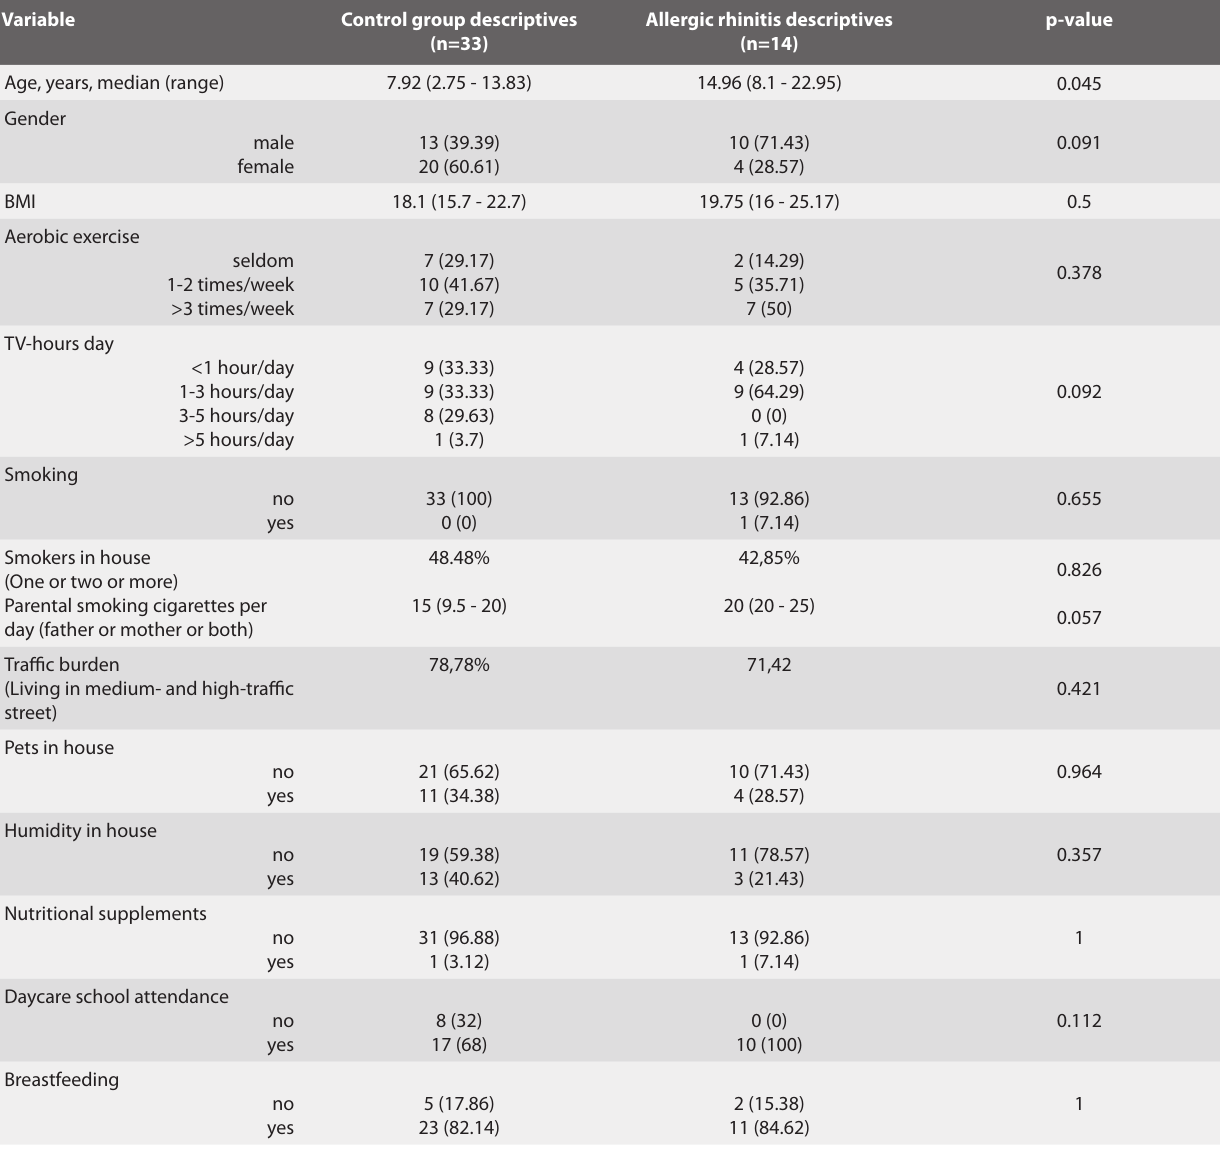
Table 1. The demographic characteristics of both healthy subjects, and subjects with allergic rhinitis. Regarding qualitative characteristics, a count (% relative frequency) is provided per variable level, while comparison among the two groups is performed with Pearson’s chi-squared test of inde- pendence. Regarding quantitative variables, descriptives are given in the form of median (25th - 75th percentile), and the p-value is extracted with Wilcoxon’s rank-sum